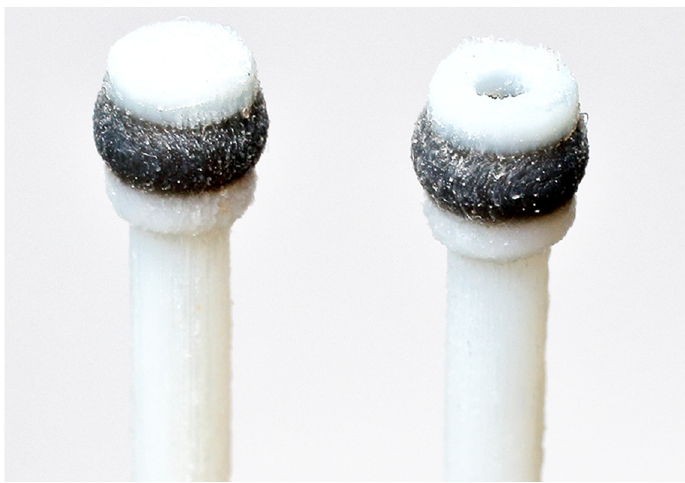
Figure 6. Three-dimensional-printed pistons integrated with the piston rod and seal [41].